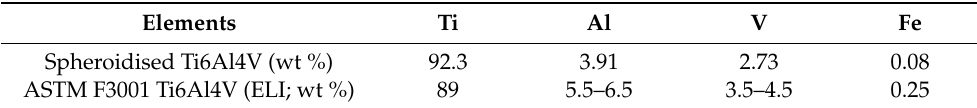
Table 4. Inductively coupled plasma-optical emission spectroscopy (ICP-OES) chemical composi- tion